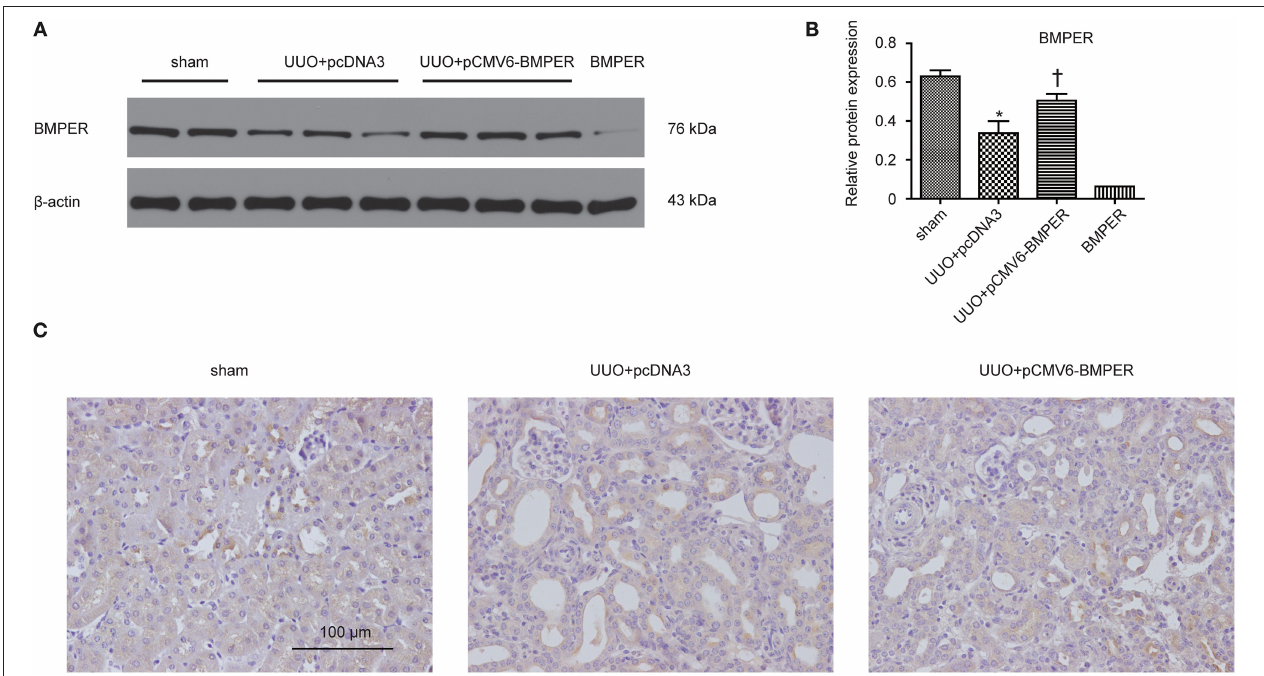
FIGURE 7 | BMPER protein levels increased in the hydronephrotic kidneys after systemic administration of pCMV6-BMPER plasmid. Kidney tissues were homogenized from sham controls and the UUO mice receiving pcDNA3 or pCMV6-BMPER. Western blot demonstrated exogenous BMPER expression in the kidneys. Purified recombinant mouse BMPER (5 ng) was loaded in the last lane (A) . The relative protein expression for BMPER in kidneys was displayed (B) . Values are the means ± SEM ( n = 6). Immunohistochemical staining for BMPER were shown (C) . Scale bar = 100 µ m. * p < 0.05 vs. sham; † p < 0.05 vs. UUO +